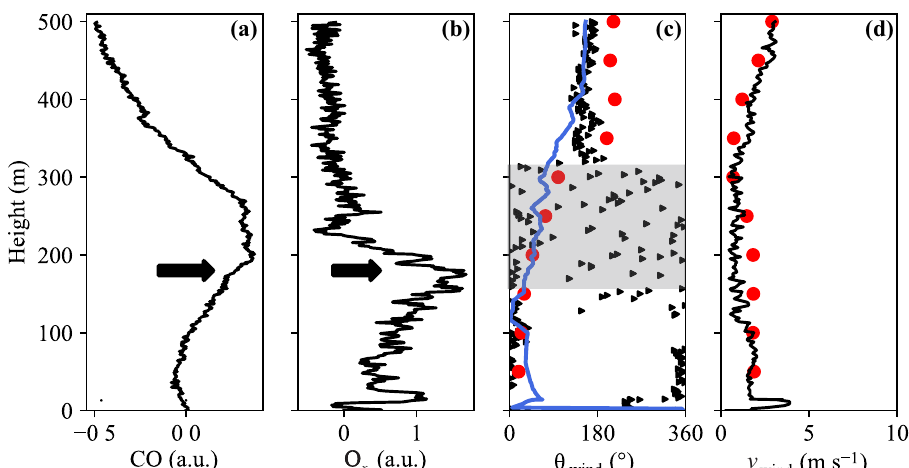
Fig. 3 Vertical pro fi les of normalized CO and O x concentrations, along with meteorological parameters, from surface elevation to 500 m for an individual UAV fl ight at 13:53 (LT) on 7 October 2019 ( fl ight 47, representative fl ight of cluster 1). a Normalized CO concentration (CO, a.u.). b Normalized O x concentration (O x , a.u.). c Wind direction ( θ wind , degrees). d Wind speed ( v wind , m s − 1 ). Horizontal arrows show in fl ection points in the vertical pro fi les. Lidar observations from the boat are in overlay as red points. The gray region highlights the altitude band across which low wind speeds occurred, and wind direction was less certain (cf. Fig. 2). For comparison, the blue line is a 50-m moving average of the UAV